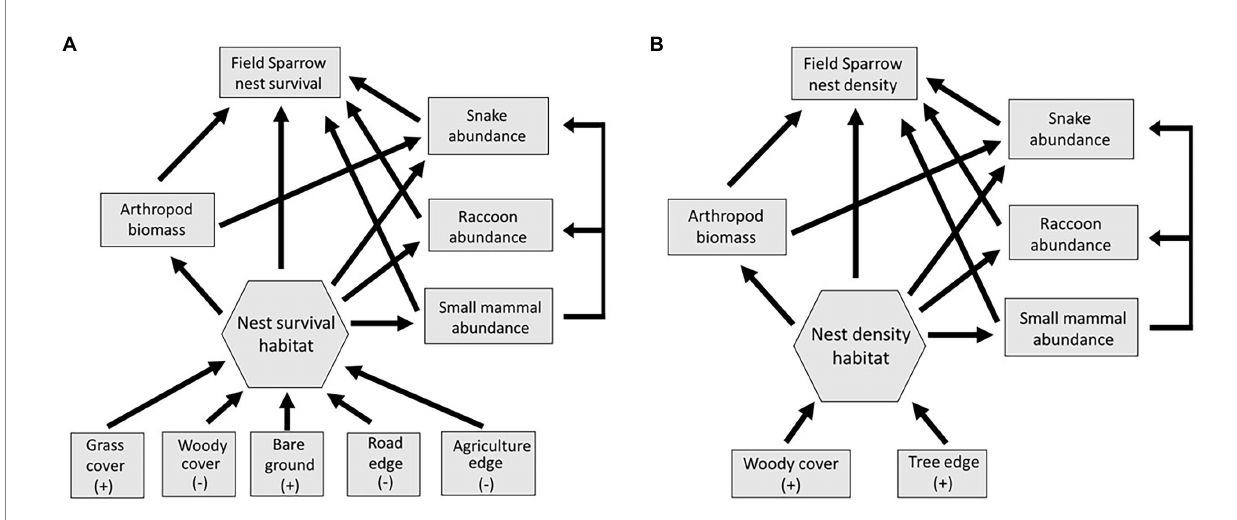
FIGURE 2 Global structural equation models containing all hypothesized direct relationships among variables that may affect nest survival (A) and nest density (B) of Field Sparrows ( Spizella pusilla ). Nest survival habitat (A) and nest density habitat (B) are composite variables comprised of habitat characteristics previously demonstrated to be associated with nest survival and nest density. The sign (+ or − ) under each habitat characteristic represents the directional effect it has on the composite